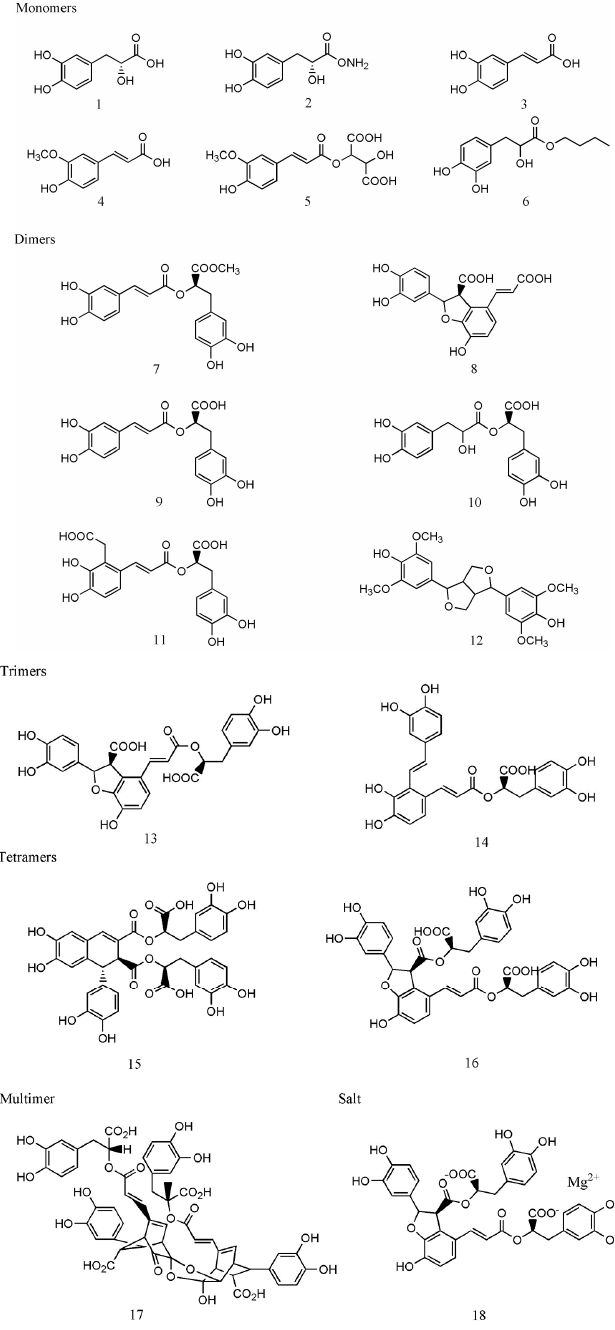
Figure 2. The representative structures of phenolic acids in Salvia species.